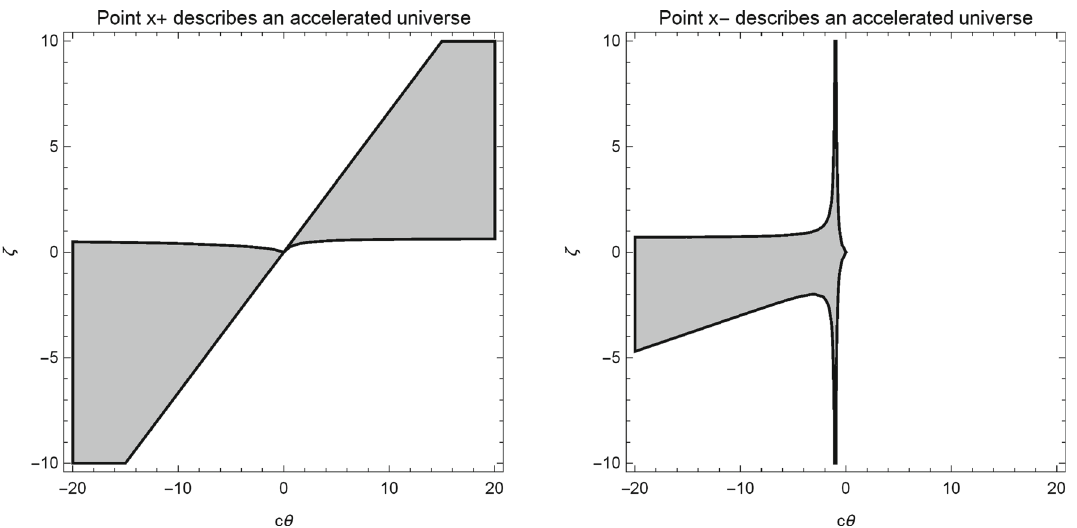
Fig. 1 Region plots in the space of parameters { c θ ,ζ } . The exact solutions at the critical points x + (left fig.) and x − (right fig.) describe accelerated